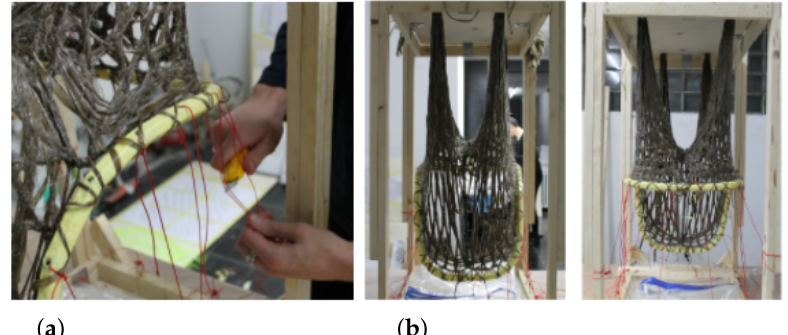
Figure 16. Forming ( a ) Tension strings being attached to the seat frame. ( b ) The prototype in the reusable frame curing at room temperature.